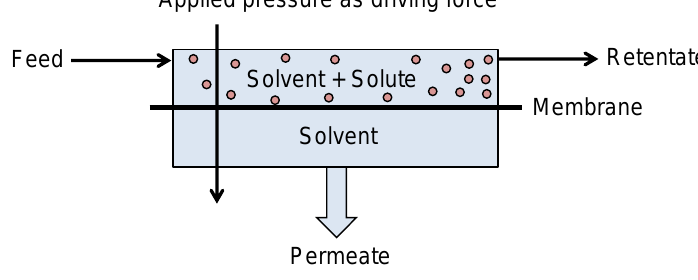
Figure 6. Schematic of a typical nanofiltration and reverse osmosis process.